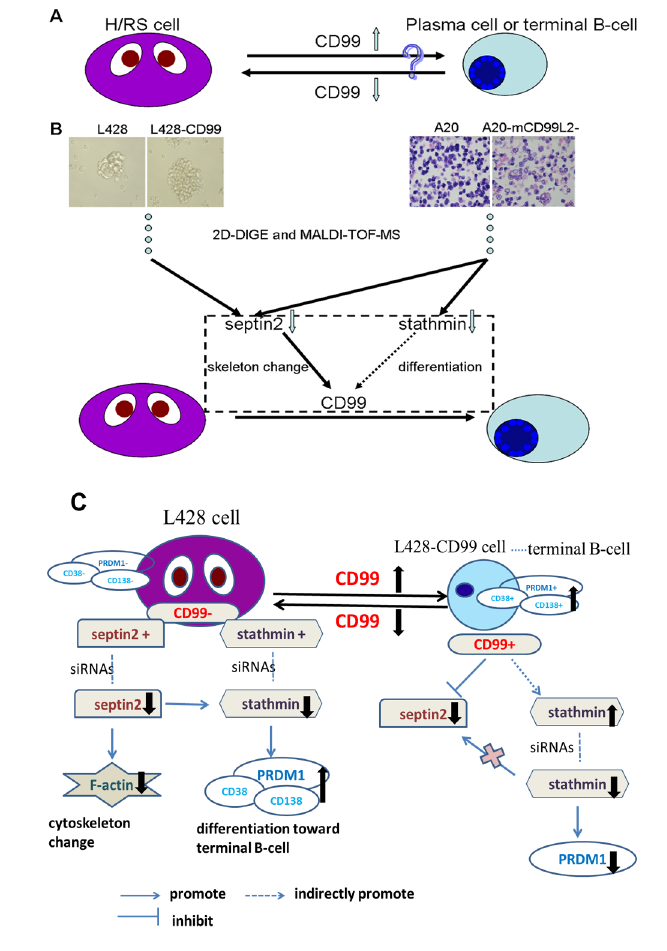
Hodgkin ’ s lymphoma (cHL) cells (L428) into terminal B-cells. (B) 2D-DIGE and MALDI-TOF MS identified differentially expressed proteins respectively in CD99 upregulation (L428- CD99) vs mock L428 cells, and in mouse CD99 antigen-like 2 (m CD99 L2) downregulation (A20-m CD99 L2-) vs mock A20 cells. SEPTIN2 and STATHMIN were chosen for further study. We found that SEPTIN2 induced the cellular cytoskeleton reorganization in L428 cells and downregulation of STATHMIN induced L428 cells differentiation toward terminal B-cells, which partially explained the observation that upregulation of CD99 induced H/RS cells to differentiate toward terminal B-cell. (C) Schematic model of the regulation of genes expression in L428 and L428- CD99 cells. Low expression of CD99 and high expression of SEPTIN2 and STATHMIN were present in L428 cells. Downregulation of SEPTIN2 with siRNAs in L428 cells induced change of F-actin expression. Downregulation of STATHMIN with siRNAs in L428 cells increased the expression of PRDM1 , CD38 and CD138, which suggests the treated cell were differentiated toward terminal B-cell. Upregulation of CD99 in L428 cells decreased SEPTIN2 while increased STATHMIN . Downregulation of STATHMIN in L428- CD99 cells with siRNAs reduced the expression of PRDM1